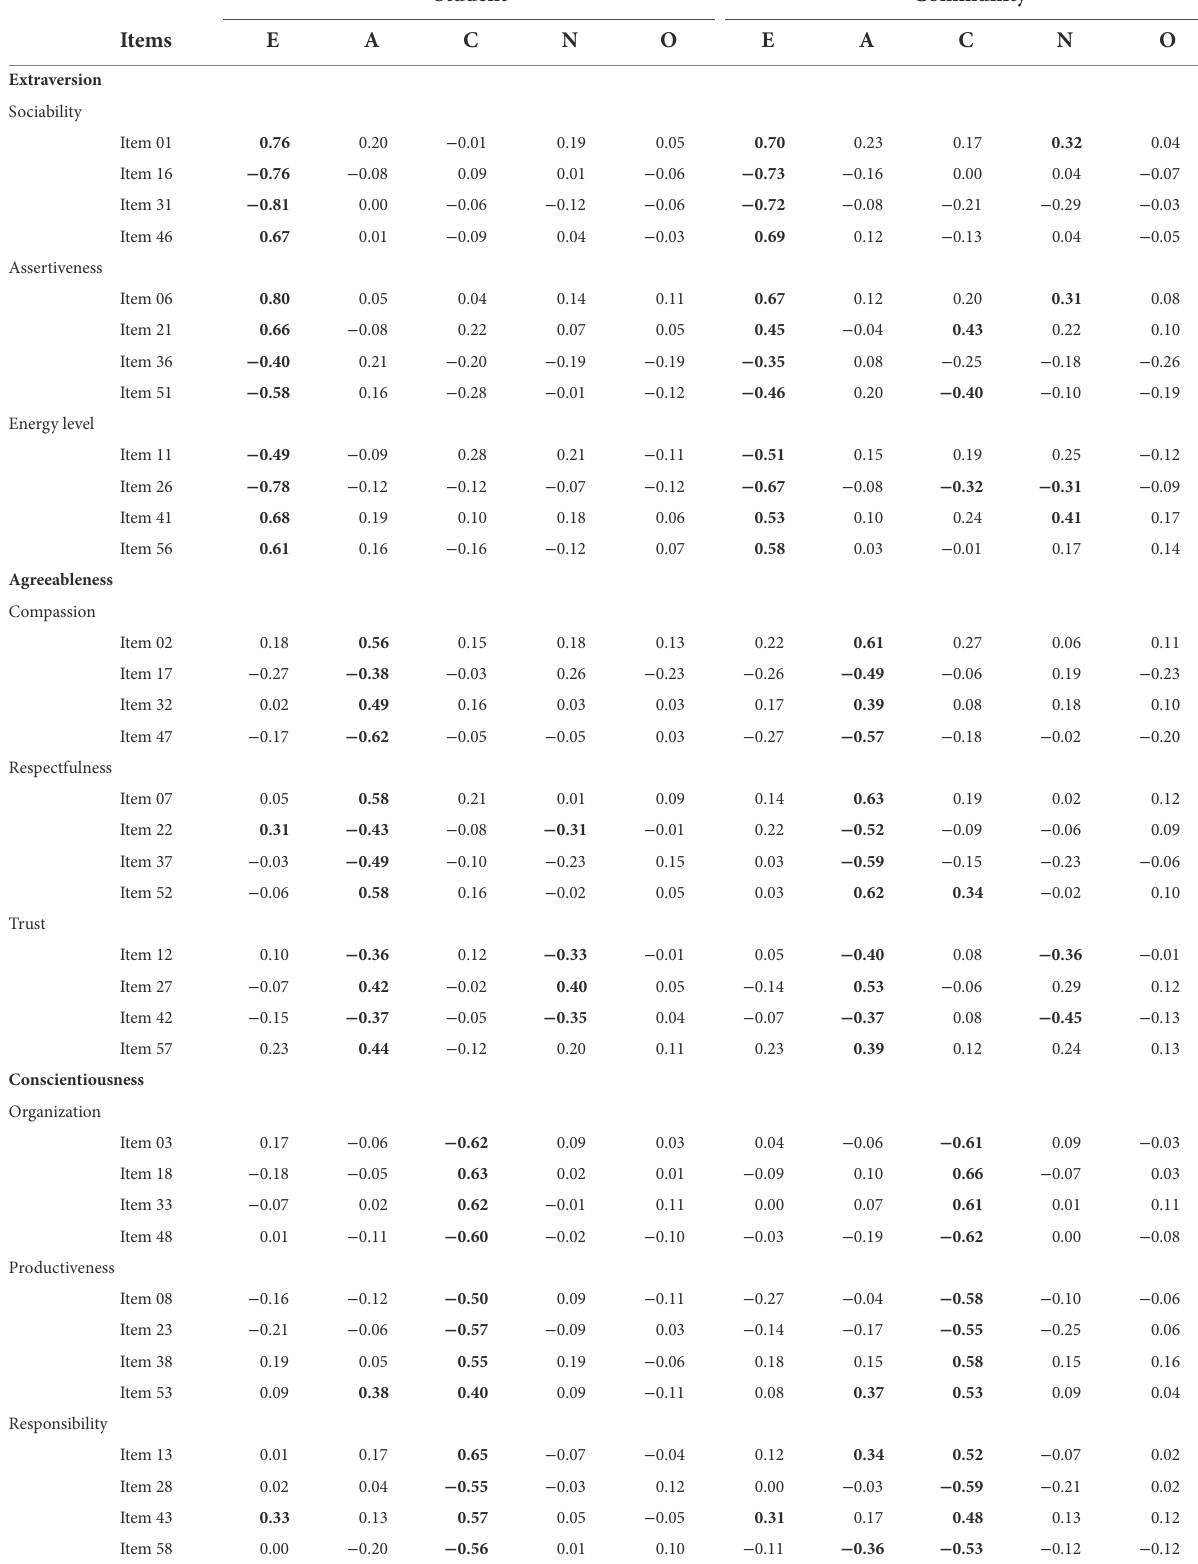
TABLE 2 Loadings from a principal components analysis of the 60